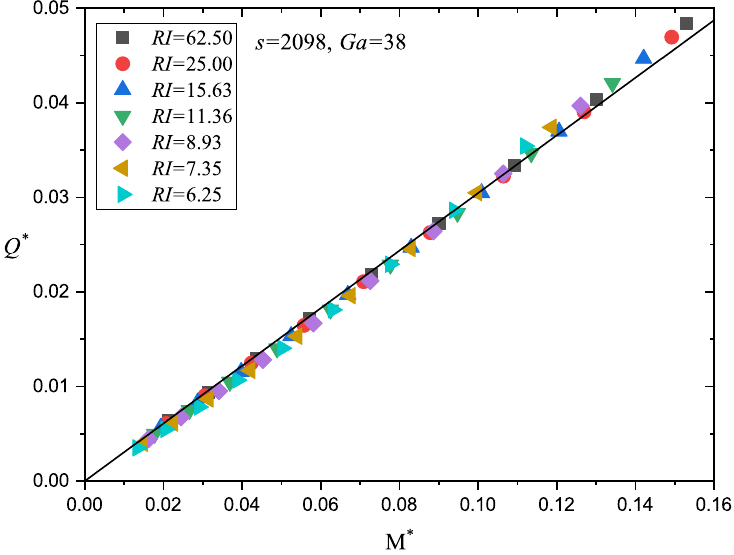
Figure 9. The relationship between Q ∗ and M ∗ . Different colors represent different ripple indexes. The result was derived from the cases with s = 2098 and Ga = 38. Solid line represents a linear